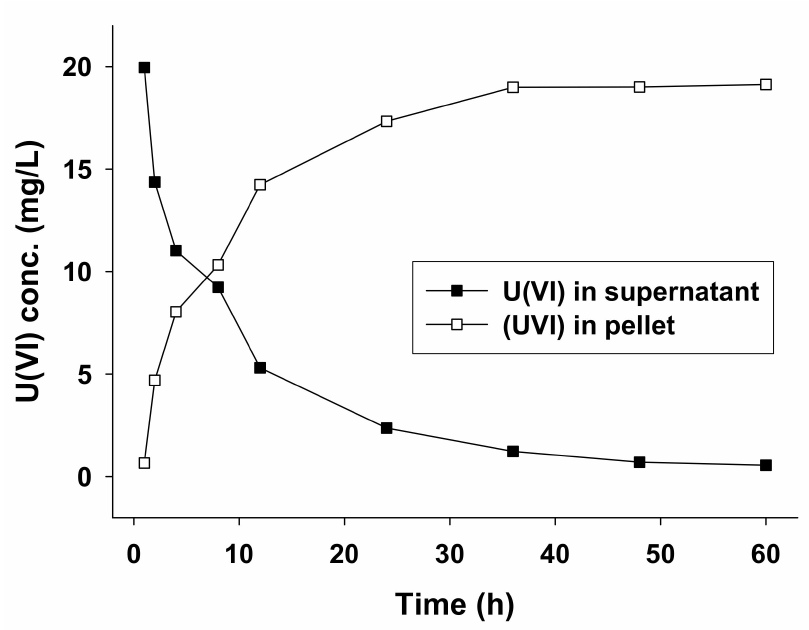
Figure 3. Biosorption of U(VI) from culture suspension by Parachlorella sp. AA1, evidenced by depletion of U(VI) in the supernatant and U(VI) accumulation in the algal cells. The supernatant and Parachlorella sp. AA1 cells were separated by centrifugation, and the U(VI) concentrations in each were measured using LC-ICP-MS. The batch experiments involved three independent